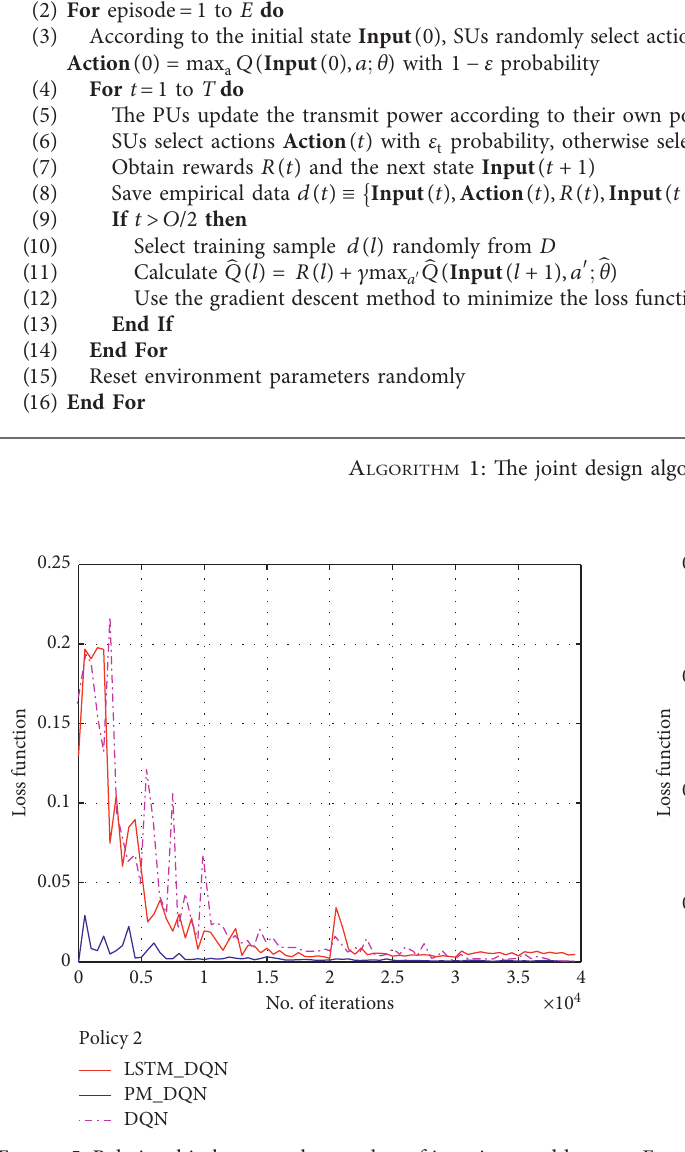
Figure 6: Relationship between the number of iterations and loss function (mix-policy).